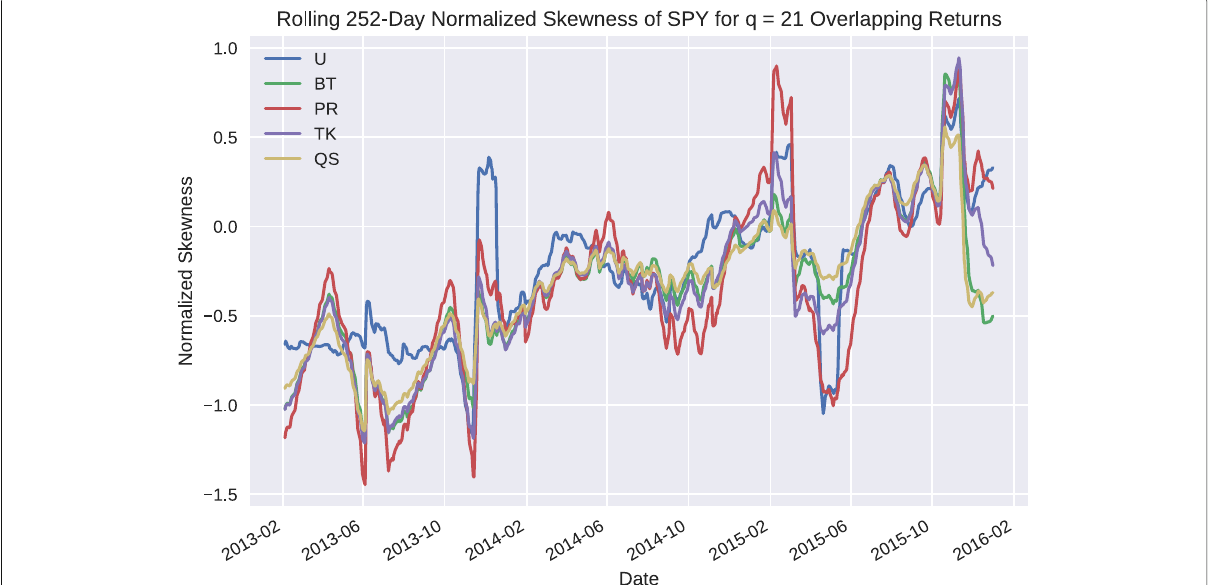
Fig. 2 Rolling n = 252 day overlapping return unbiased skewness for HAC weighting schemes and a n = 126 lookback period for uniform weights with a q = 21 overlapping period for SPY daily